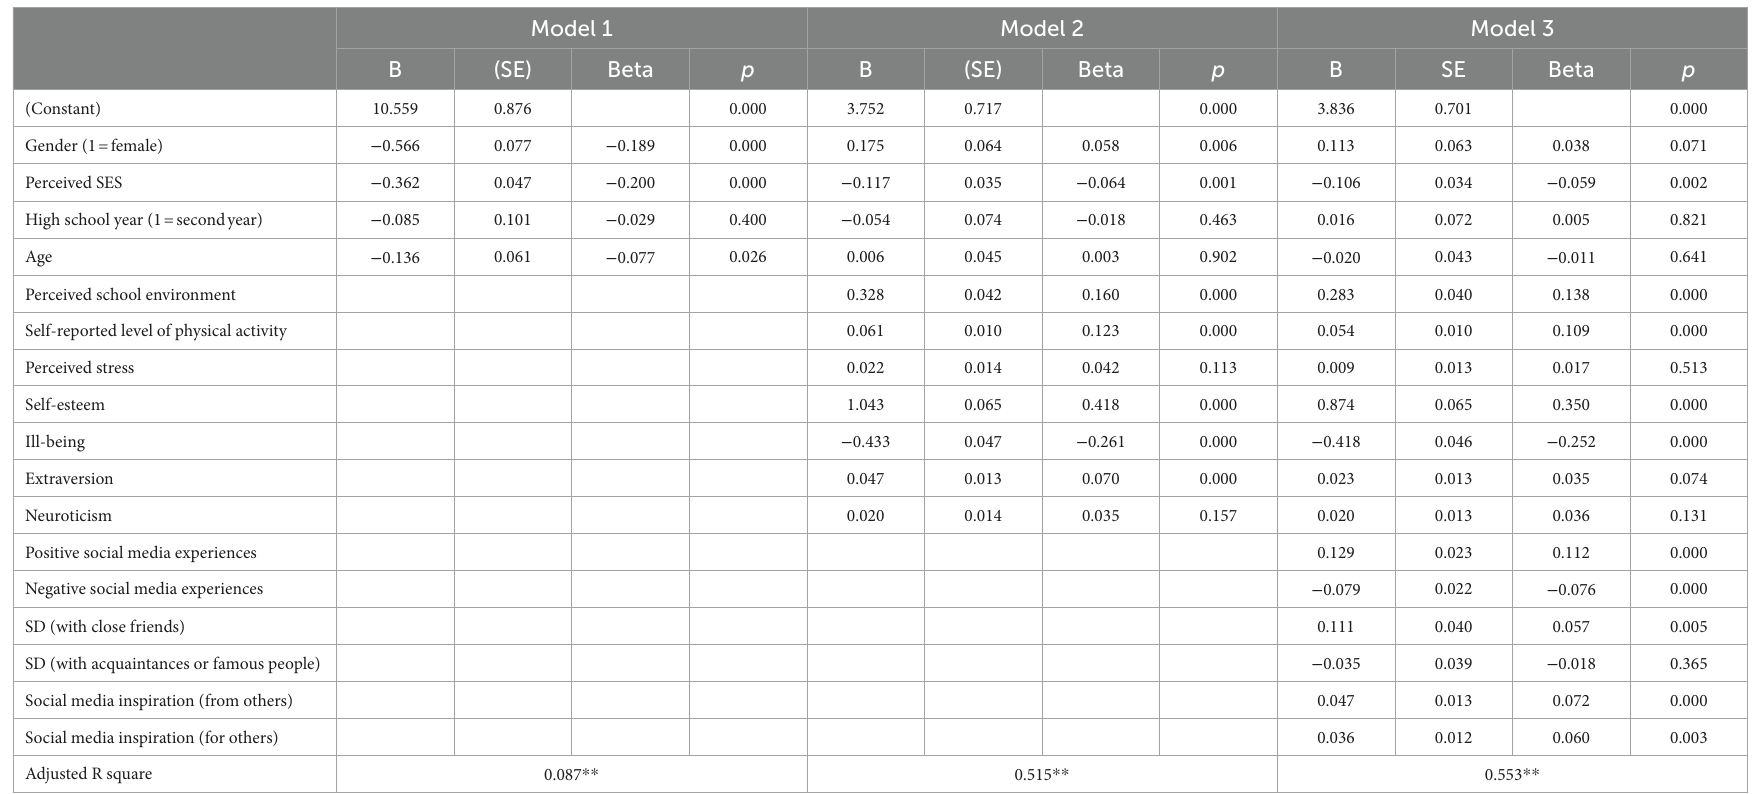
TABLE 3 Hierarchical regression results with flourishing as